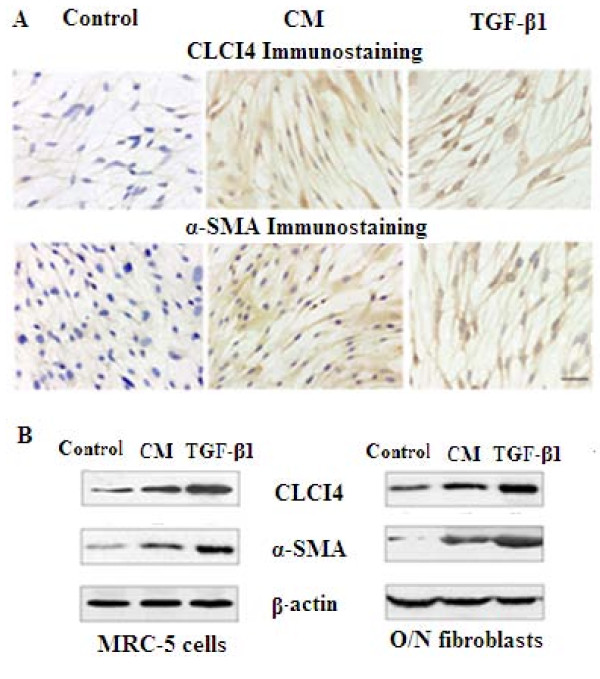
Immunohistochemical staining of CLIC4 and α-SMA. (A). In cultured fibroblasts (control) and transdifferiated myofibroblasts (activated by CMSKOV3 (CM) and TGF-β1). Scale bar, 50 μm. (B) Western blot of MRC-5 cells or primary ovarian fibroblasts cultured in serum-free medium (control), in CM or TGF-β1 for 48 hours.